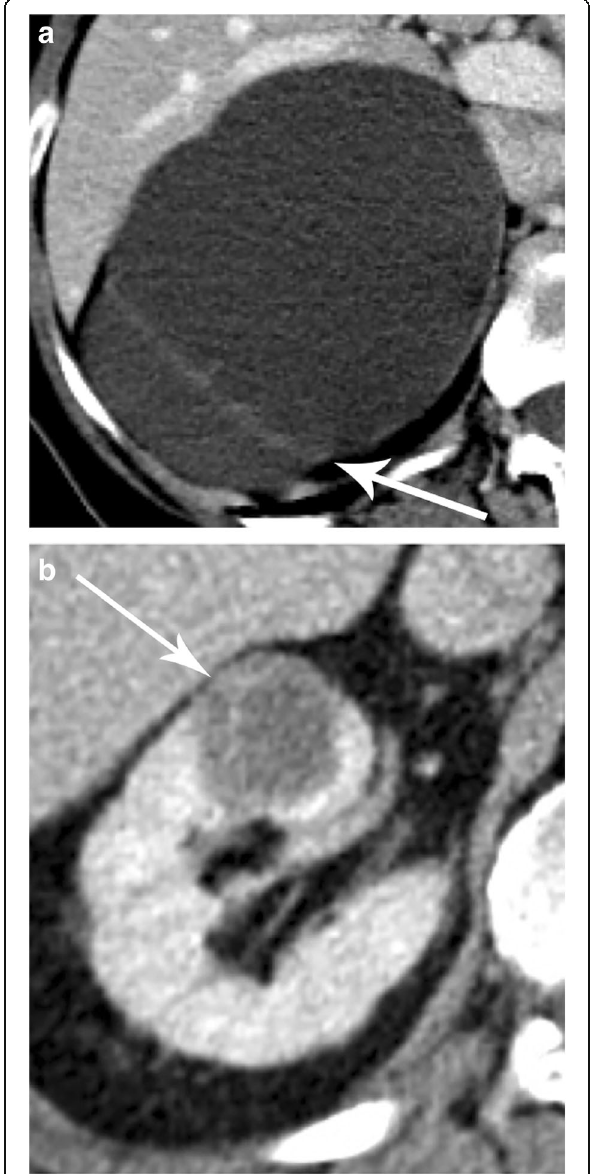
Fig. 15 Bosniak IIF, differentiation between low and more complex lesions. a Axial contrast-enhanced CT depicting a large cyst with a solitary thick septum. The cyst should be followed because the septum is thick, but suspicion of malignancy is very low (arrow). b Axial contrast-enhanced CT demonstrating a cyst with multiple septa. This complex appearance does not completely rule out a possible cystic tumor